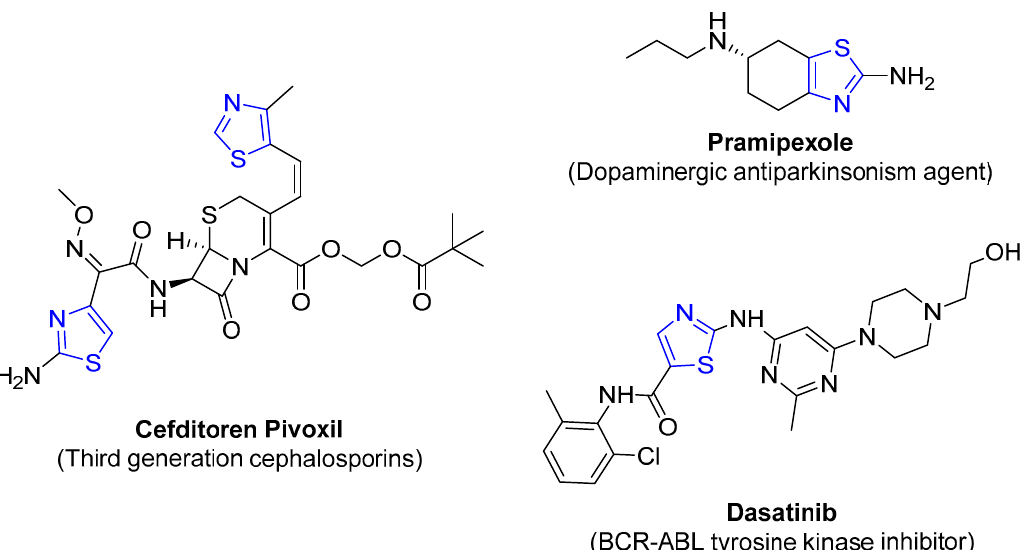
Figure 5. Drugs containing a thiazole ring.